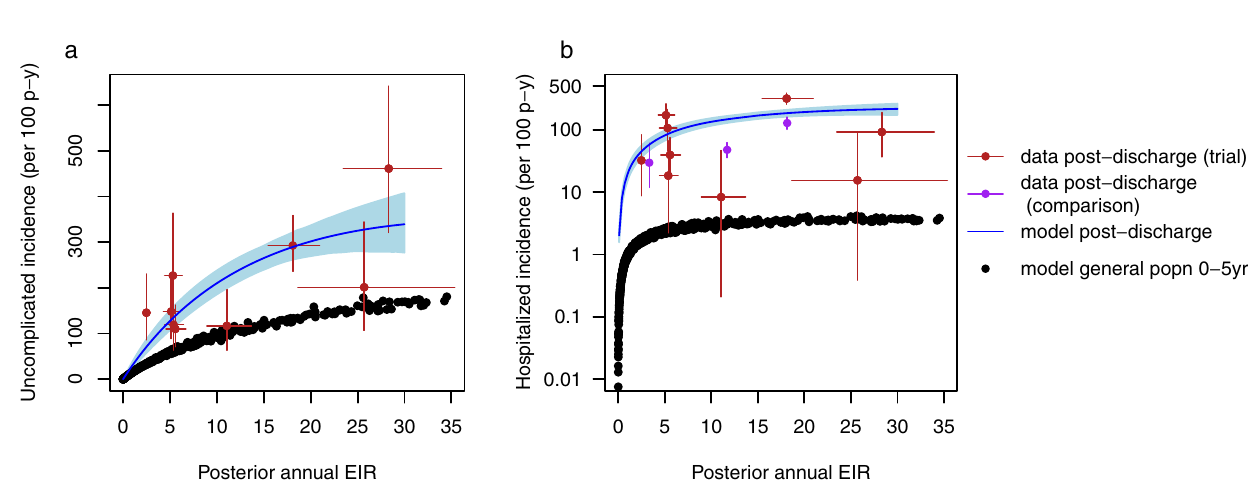
medians and 95% credible intervals (CI) (see Table S4 for data and model predic- tions). b Cumulative daily number of hospitalised malaria cases by time since dis- charge after the original SMA episode in placebo (black) and PDMC (blue) trial arms;solidline=data,dashedlineandshadedarea=modelmedian fi tand95%CI.( c ) As ( b ), for uncomplicated malaria